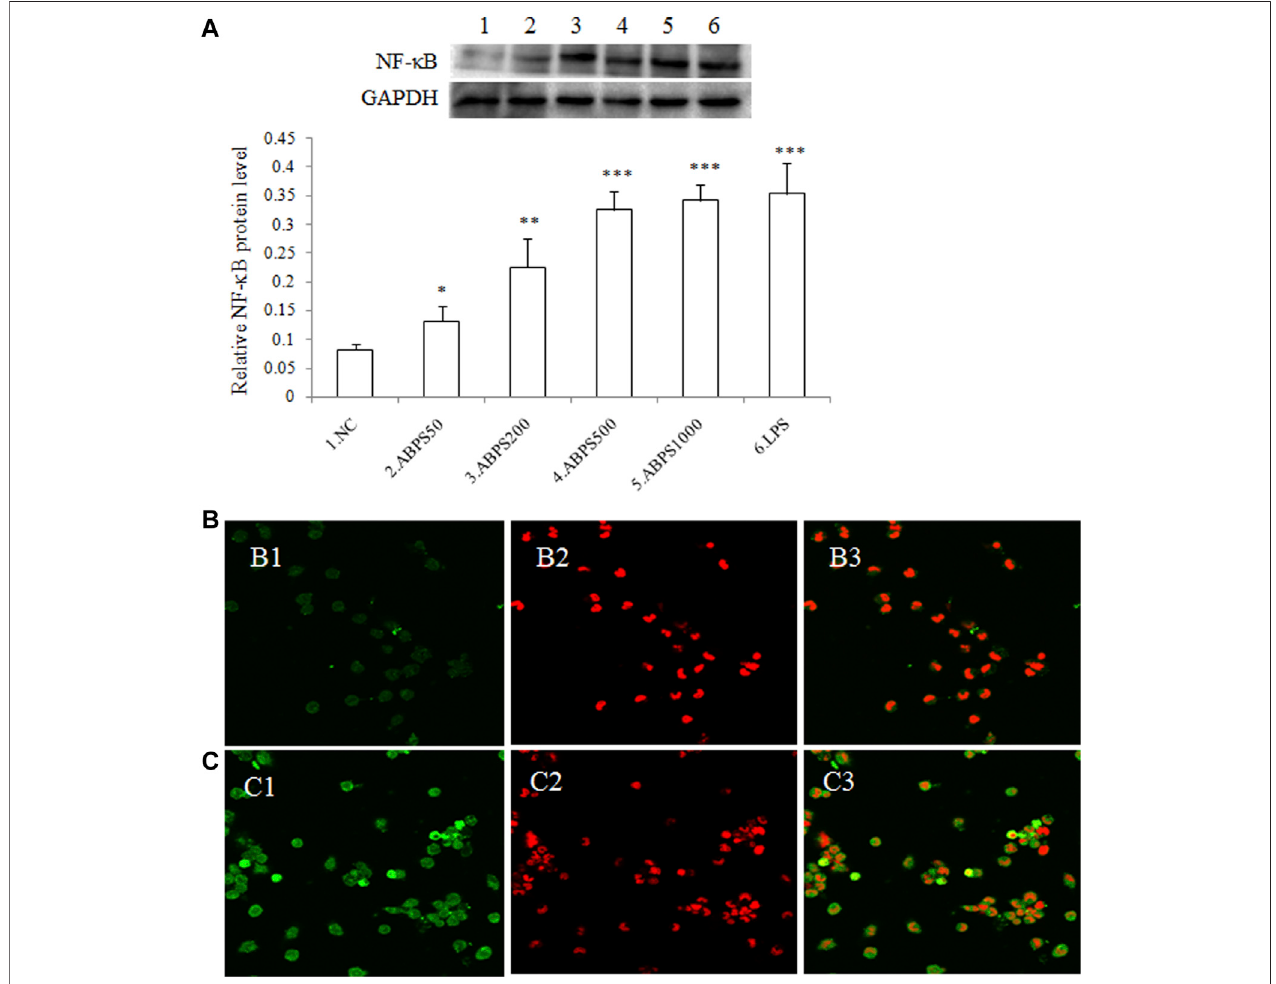
FIGURE5| EffectofABPSontheexpressionandnucleartranslocationofNF- κ BinJ774 A.1cells. (A) TheexpressionofNF- κ BinJ774 A.1.Cellsweretreatedwith ABPS (0, 50, 200, 500, and 1,000 μ g/ml, respectively) or LPS (5 μ g/ml) for 24 h. Nuclear extracts were prepared and determined by western blot. NC: normal control; ABPS50: 50 μ g/ml ABPS treated; ABPS200: 200 μ g/ml ABPS treated; ABPS500: 500 μ g/ml ABPS treated; ABPS1000: 1,000 μ g/ml ABPS treated; and LPS: 5 μ g/ml LPStreated(positivecontrol).* p < 0.05, ** p < 0.01, *** p < 0.001 vs. NC.Thevaluesarepresentedasmeans ± SD. (B) and (C) ABPSpromotednucleartranslocation ofNF- κ B.CellswerestainedwithFITC-taggedantibody(B1:control;C1:500 μ g/mlABPS)orpropidiumiodide(PI)(B2:control;C2:500 μ g/mlABPS).Micrographs(B3: control; C3: 500 μ g/ml ABPS) represent merged images obtained through the red and green fl uorescence